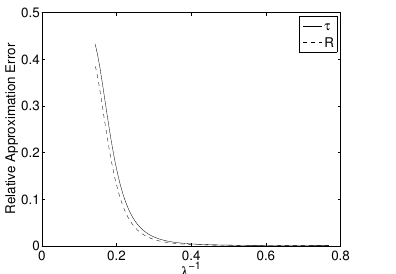
ror for R and τ , Strategy 1